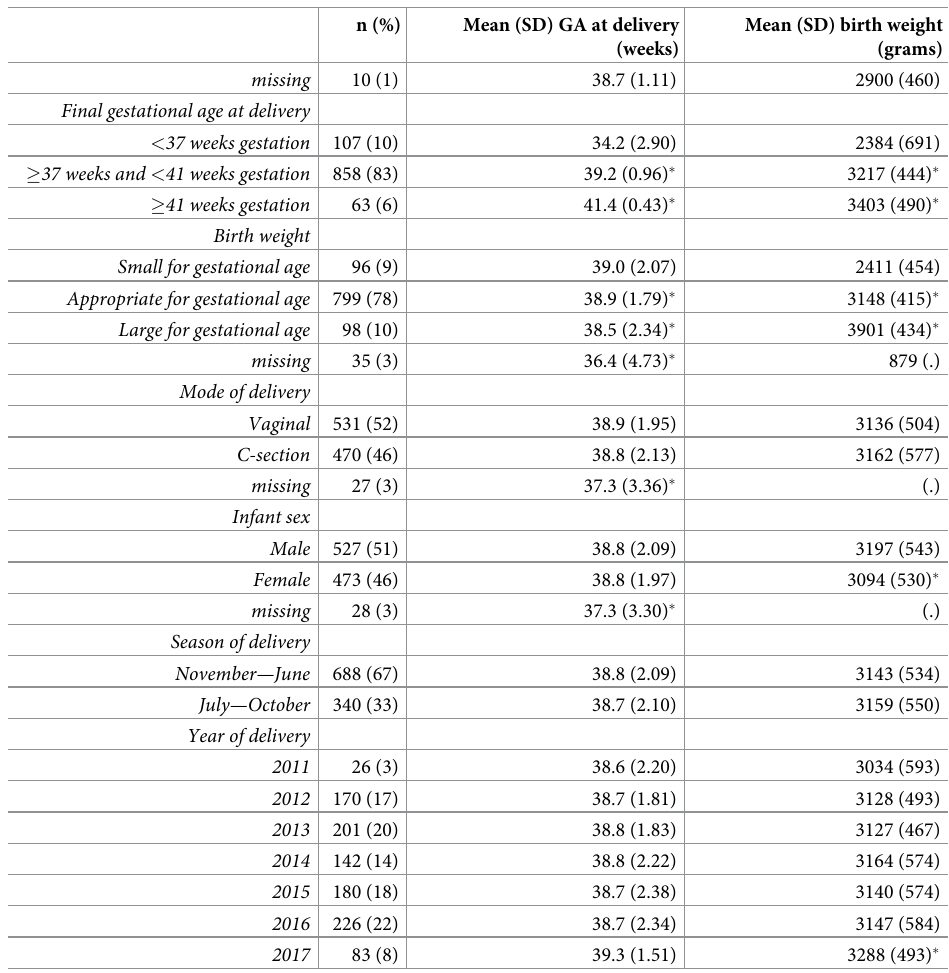
� p < 0.05 for difference from reference (first level, or 2014 for year of delivery). p for trend over time (2011 to 2017) = 0.21 for gestational age and 0.09 for birth weight. Notes: Missing SD values “(.)” reflect cells where only one participant contributed data. For mode of delivery and infant sex, all participants who were missing data were also missing birth weight at delivery. Abbreviations: SD, standard deviation; GA, gestational